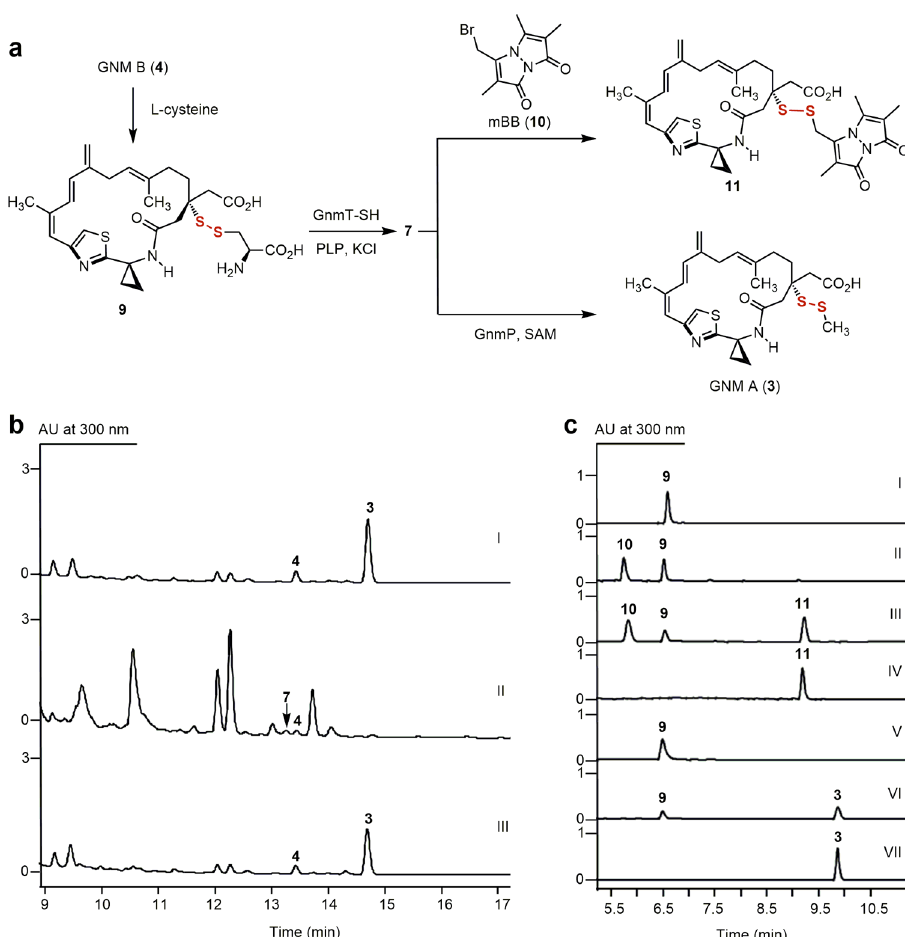
Fig. 2 In vivo and in vitro characterization of GnmP as a SAM-dependent hydropersul fi de methyltransferase, establishing 7 as the penultimate intermediate for 3 biosynthesis. a Chemoenzymatic synthesis of 7 from 4 and a GnmT-SH and GnmP-coupled assay of GnmP-catalyzed S -methylation of 7 to 3 using 9 as a surrogate substrate. b HPLC analysis of metabolite pro fi les: (I) S . sp. CB01883 (wild-type), (II) SB21007 ( Δ gnmP ), and (III) SB21008 ( Δ gnmP / gnmP ). c HPLC analysis of in vitro assays: (I) substrate 9 , (II) 9 + GnmT-SH (boiled) + 10 , (III) 9 + GnmT-SH + 10 , (IV) product 11 , (V) 9 + GnmT-SH (boiled) + GnmP (boiled) + SAM, (VI) 9 + GnmT-SH + GnmP + SAM, and (VII) product 3 . Substrate and enzyme concentrations used: 9 , 0.5 mM; SAM, 2 mM; GnmT-SH, 10 μ M; and GnmP, 30 μ M. Incubation time: 20 min. The concentration of 10 used to trap 7 in situ as 11 : 0.5 mM. “ AU ” denotes absorbance